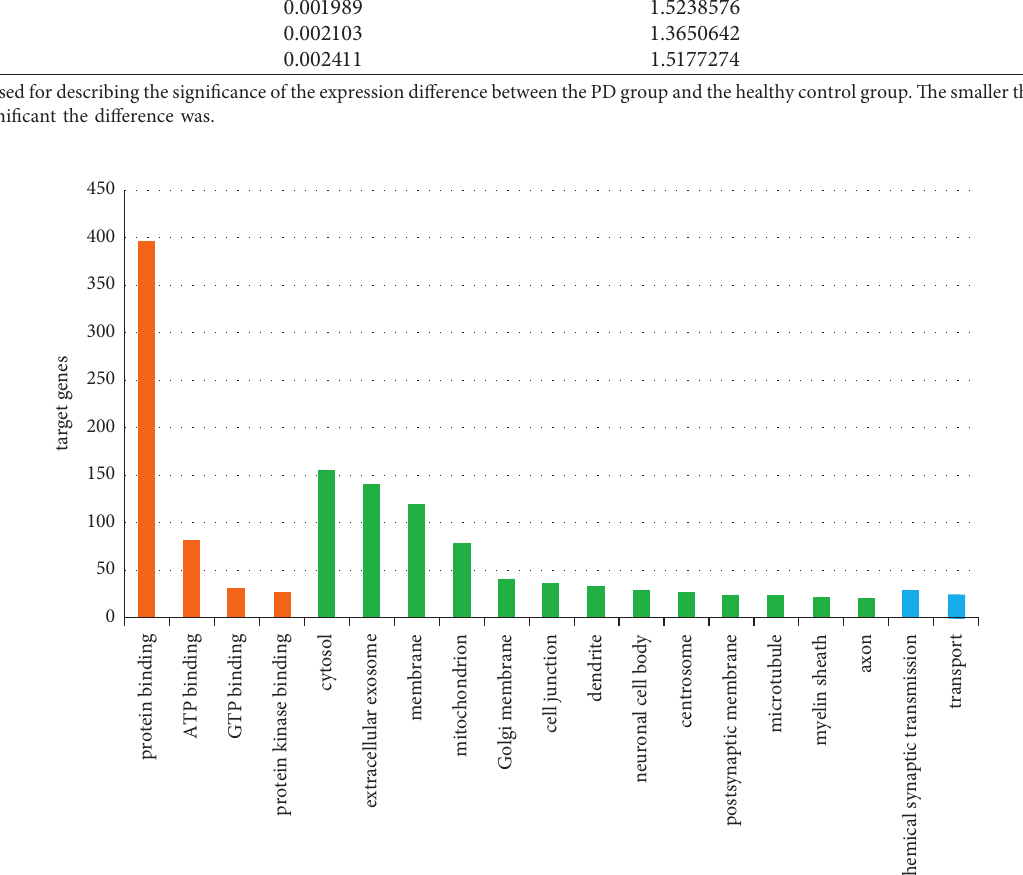
Figure 3: GO function enrichment analysis of DEGs. Orange represents MF, green represents CC, and blue represents BP. The numbers on the y -axis are gene